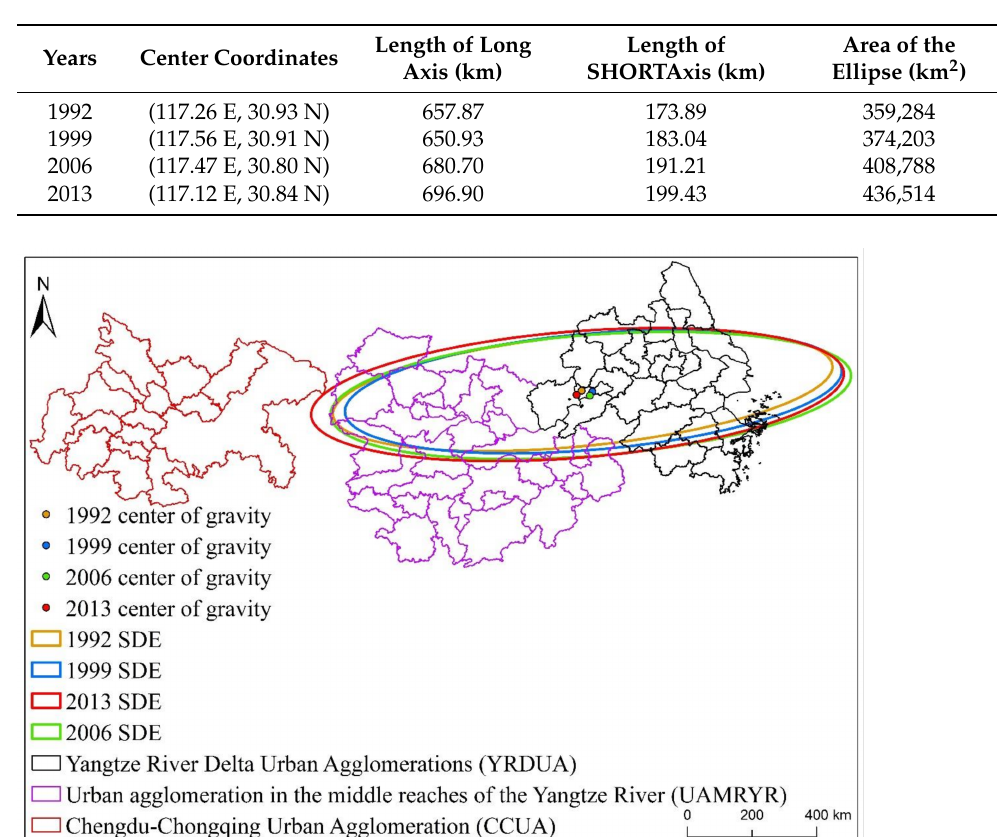
Table 1. Statistical table of the standard deviation ellipse data of the three major urban agglomerations of YREB in 1992–2013.